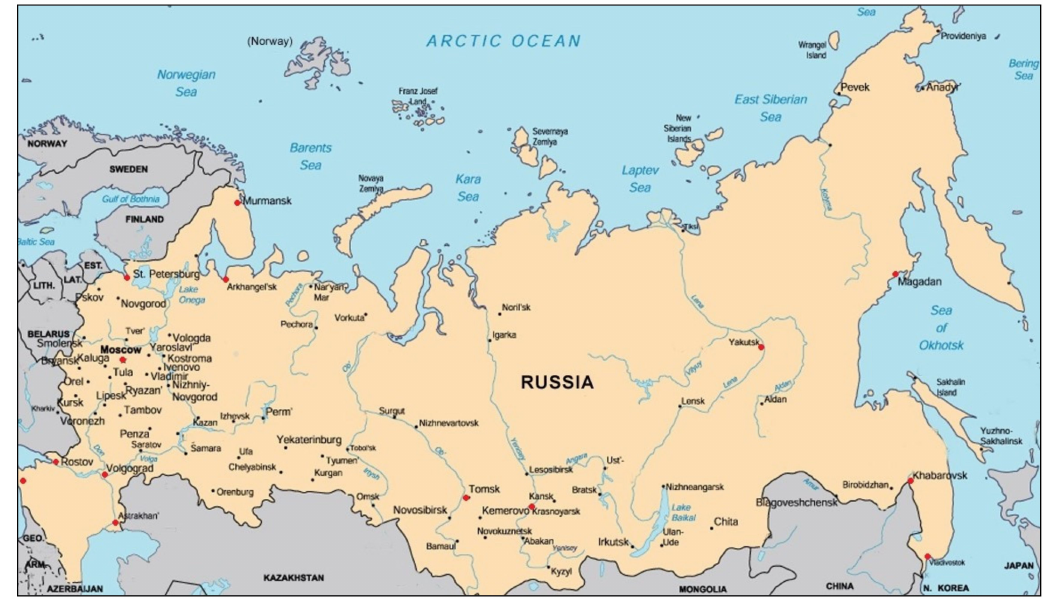
Figure 1. Map of Russia, where red dots show location of weather stations mentioned in the study. Table 1. General information on Weather Stations mentioned in the